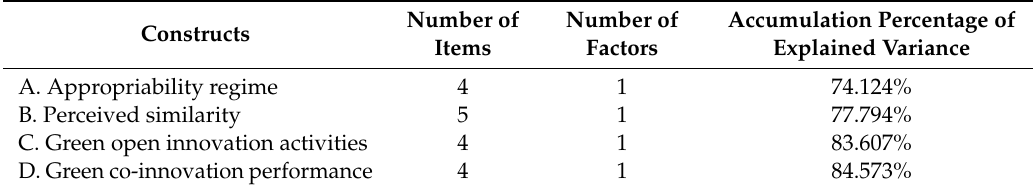
Table 4. Factor analysis.